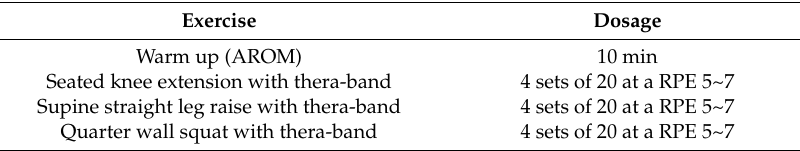
Table 2. Quadriceps muscle strengthening